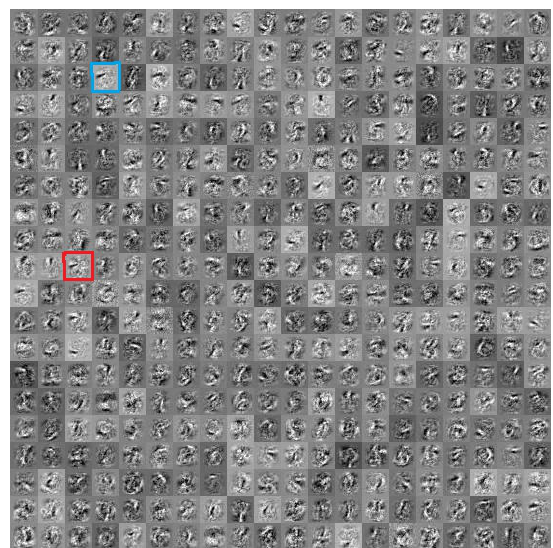
Figure 4. Visualization of neurons in the first hidden layer of the original DBN.